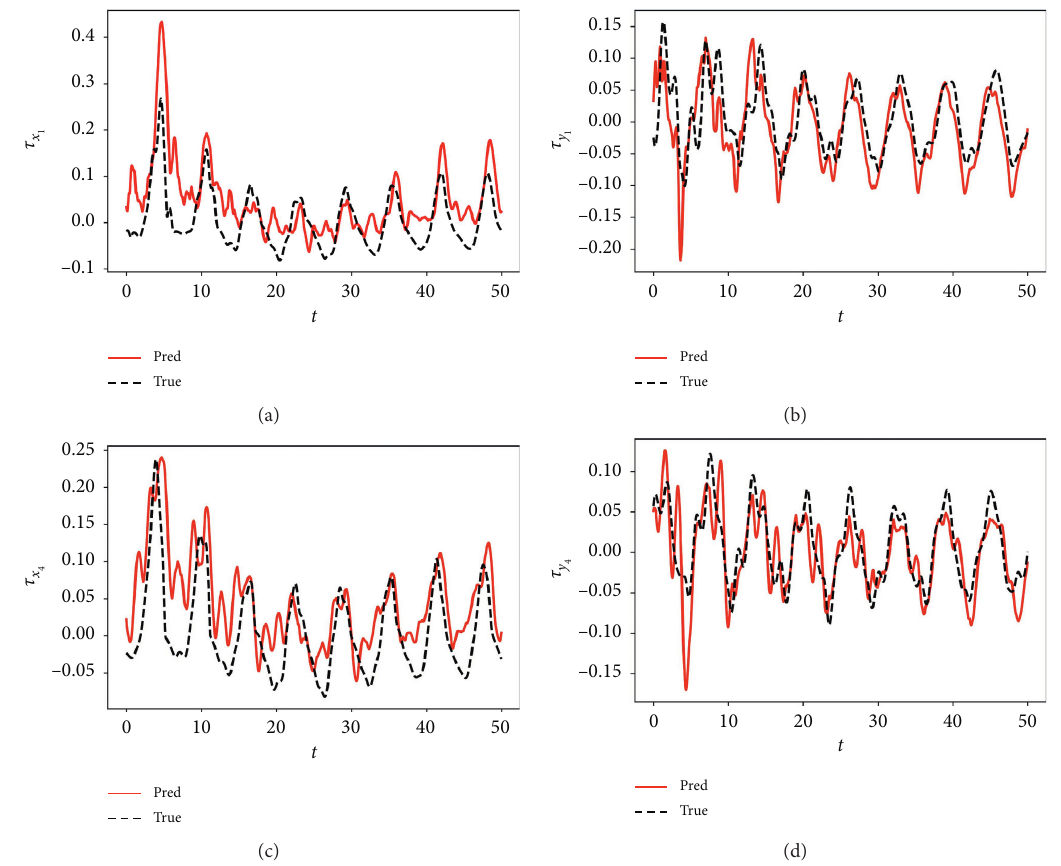
Figure 4: The prediction values of the bearing forces after the training process: (a) horizontal component of bearing force at the left end; (b) vertical component of the bearing force at the left end; (c) horizontal component of the bearing force at the right end; and (d) vertical component of the bearing force at the right end.